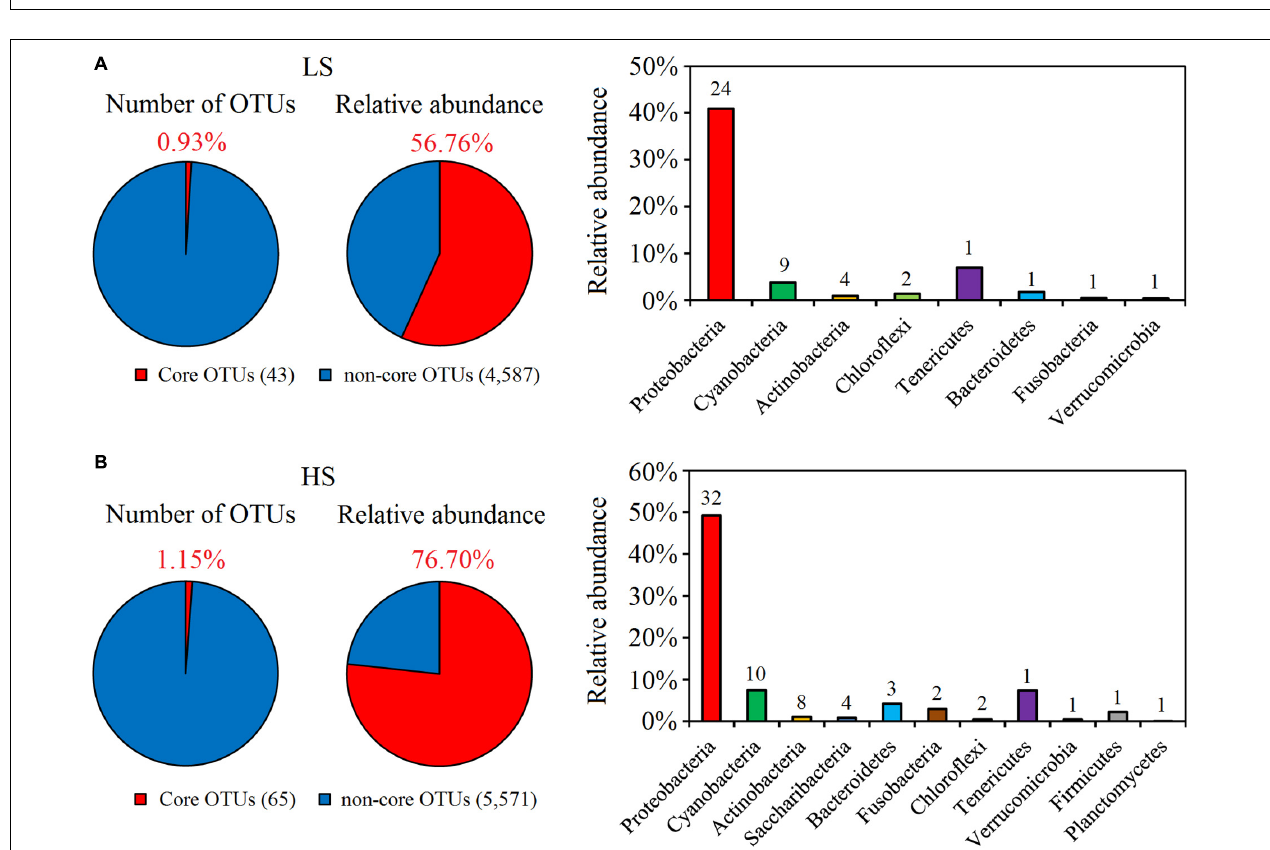
FIGURE 2 | Abundance and composition of core OTUs of shrimp intestine in the LS and HS groups. (A) Forty-three OTUs were identified as the core OTUs in the LS group, accounting for 56.76% of all intestine bacterial sequences obtained, which belonged to Proteobacteria, Cyanobacteria, Actinobacteria,